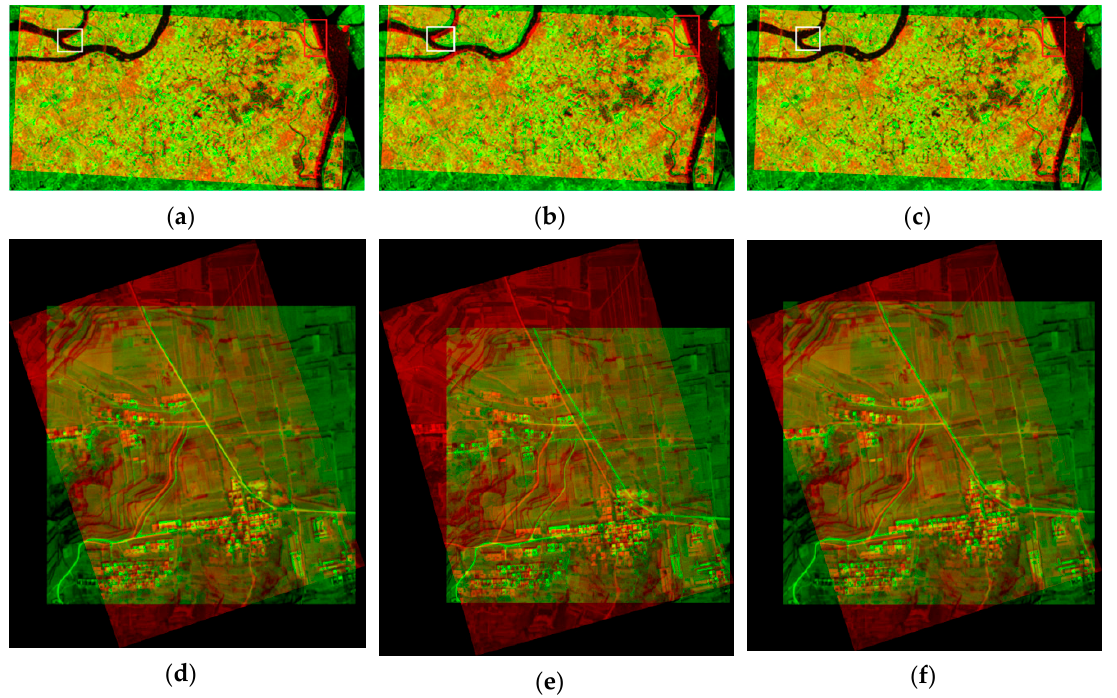
Figure 5. Feature-based preregistration results using different edge points extraction methods. ( a ) and ( d ) use the Canny algorithm to obtain edge points; ( b ) and ( e ) use the phase convergence model to obtain edge points; ( c ) and ( f ) use the ANDD-based ESM to obtain edge points.